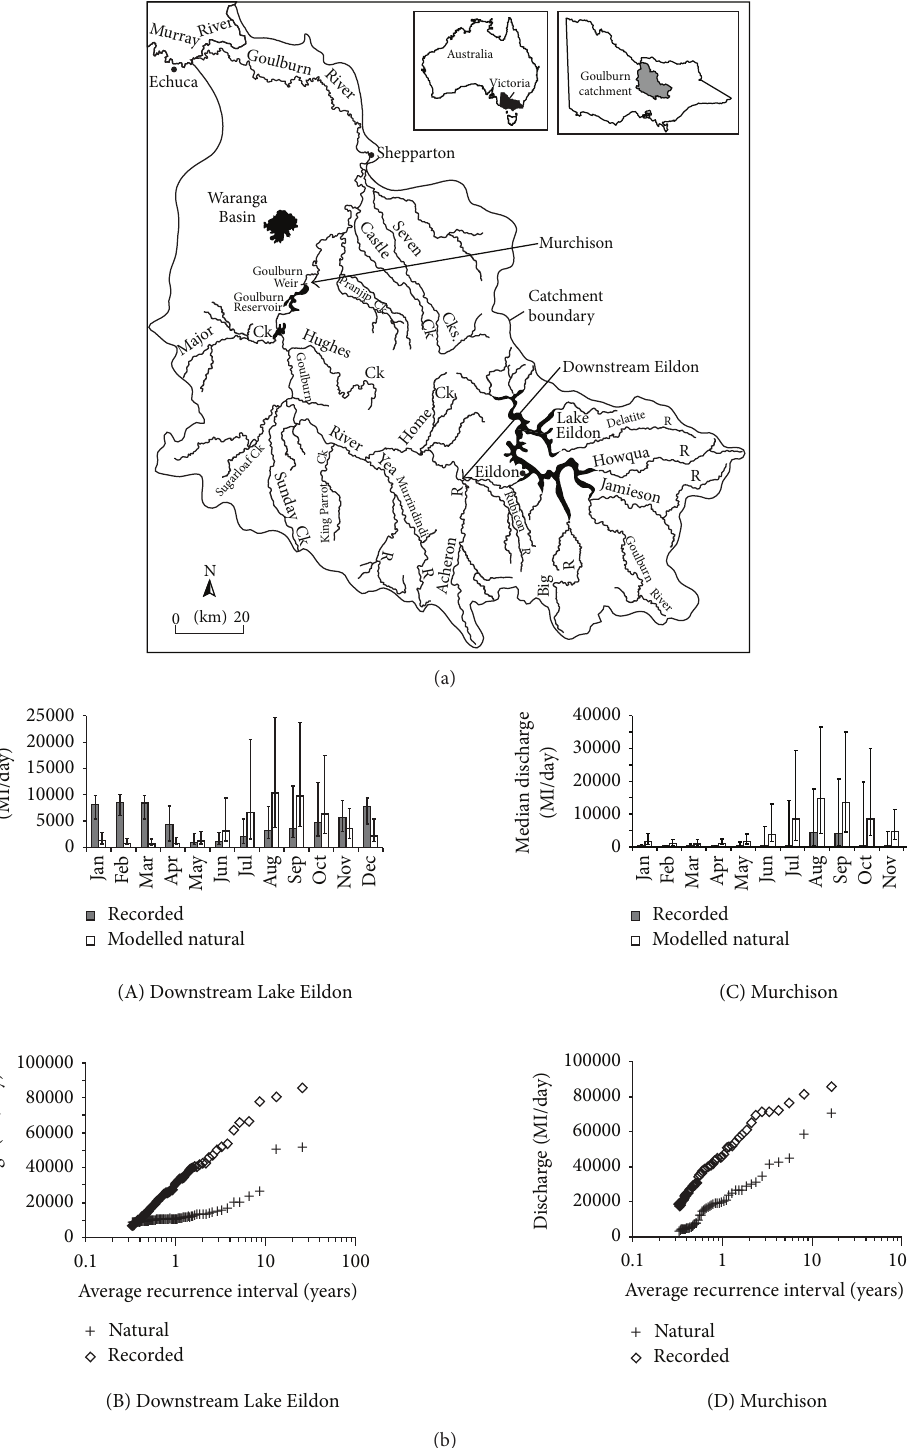
Figure 4: (a) Location map of the Goulburn River in Victoria, southeast Australia. (b) Recorded flows (under dammed conditions) compared with modelled natural flows for two locations on the Goulburn River. Eildon is immediately downstream of the major dam within the catchment. Murchinson is located midcatchment, downstream of Goulburn Weir, a major offtake and flow control structure. (a) and (c) are based on median monthly flows. (b) and (d) are flood frequency curves based on the partial